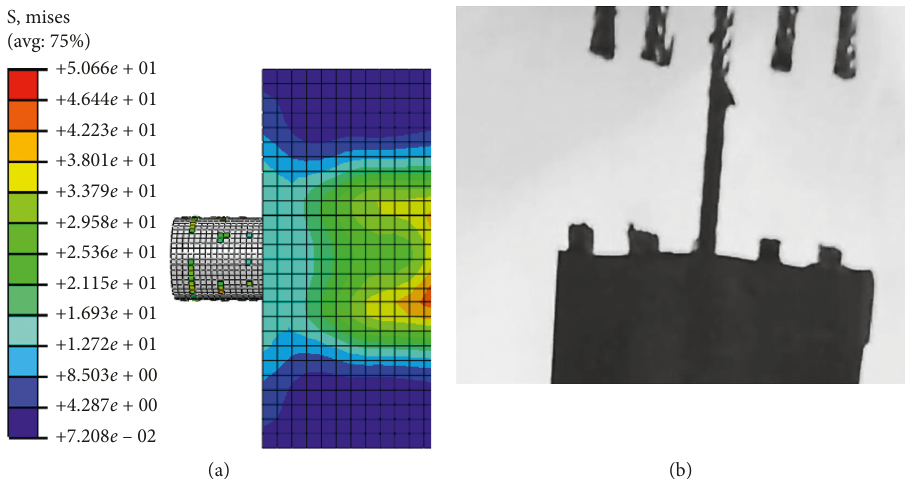
Figure 5: Steel cord and rubber separation. (a) Simulation result. (b) Experimental